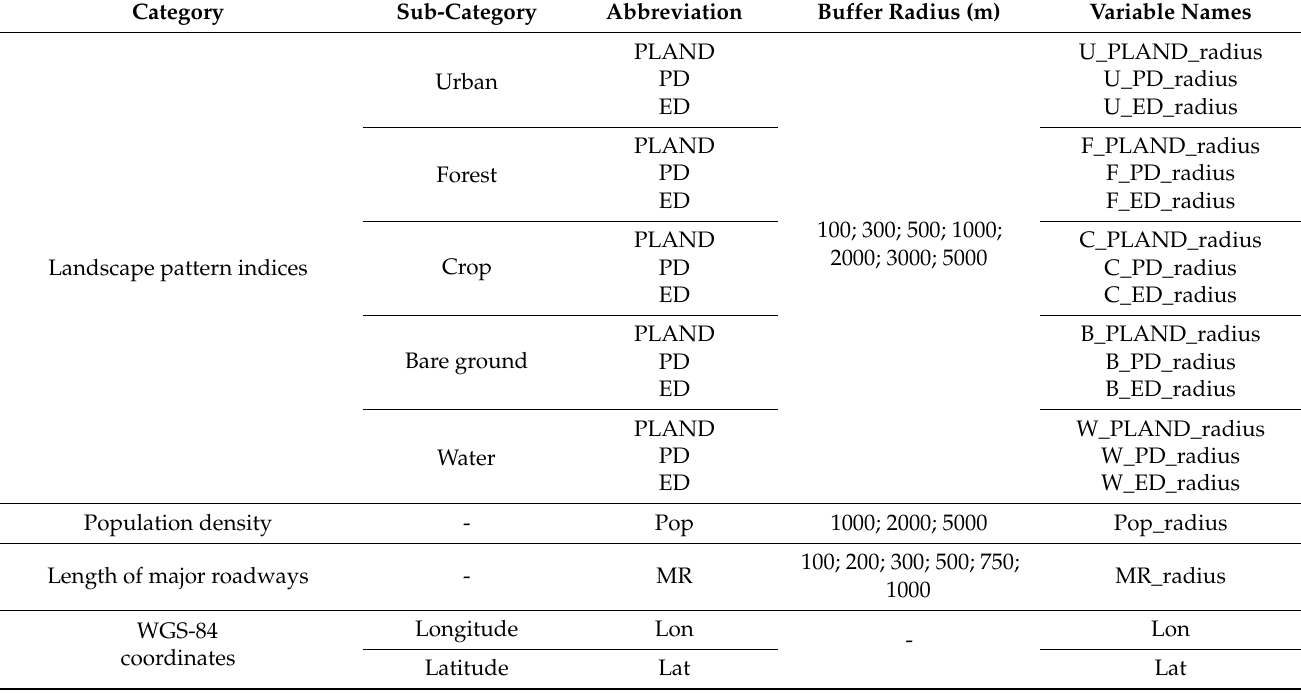
Table 1. List of independent variables used for regression analyses. The format of this table is adapted from Wu et al.